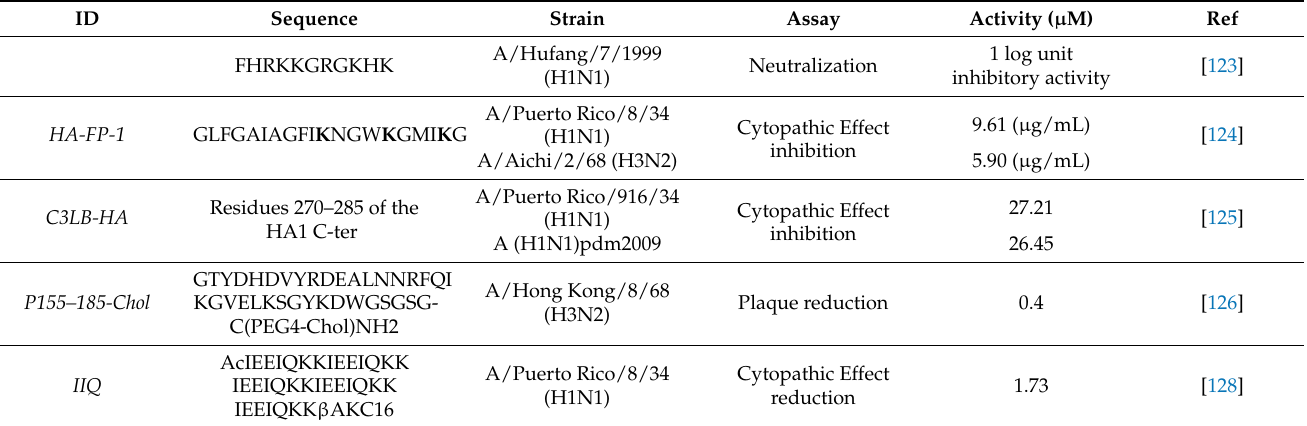
Table 3. Most representative peptides interfering with the fusogenic activity of